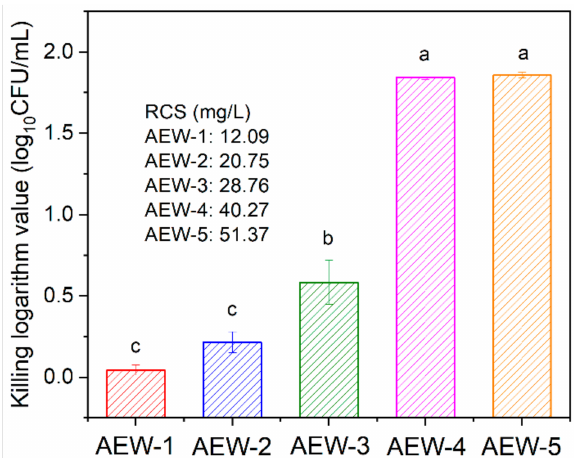
Figure 2. Sterilization effects of AEW with different RCS contents on the bacterial suspension of B. subtilis . Values with different lowercase letters above graph bars represent a significant difference ( p <